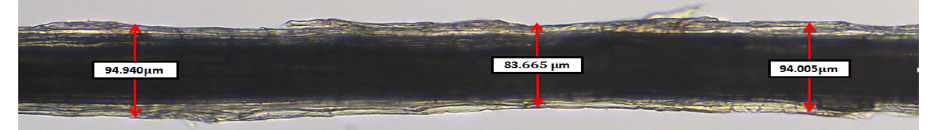
Figure 2. Optical microscopic image of Corypha taliera fruit